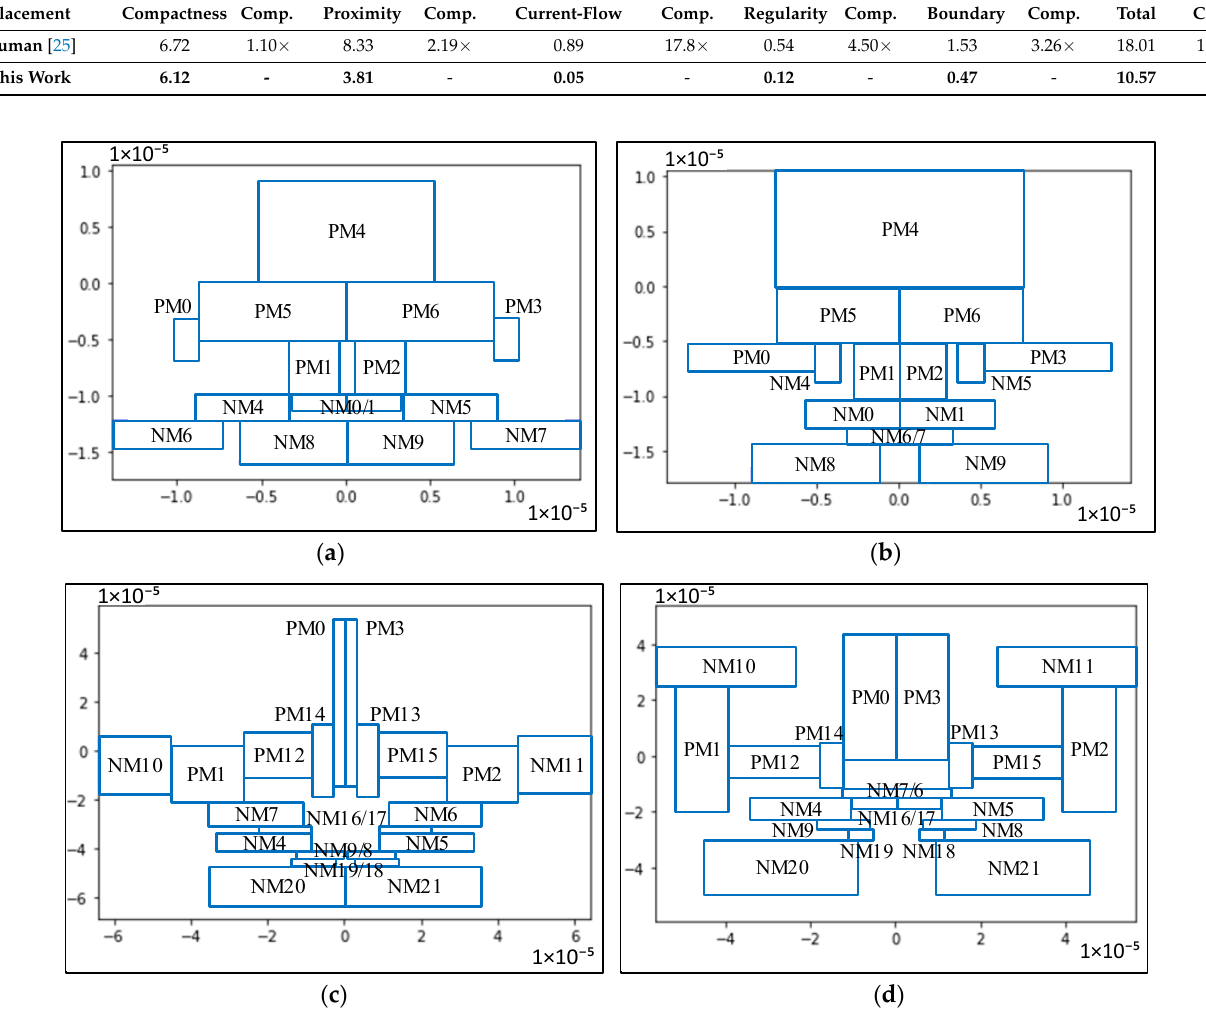
Figure 6. Test set predictions: ( a , b ) FVC (tsmc65); ( c , d ) VCOTA. Table 4. Train (TrE), validation (VaE), and test (TeE) errors.